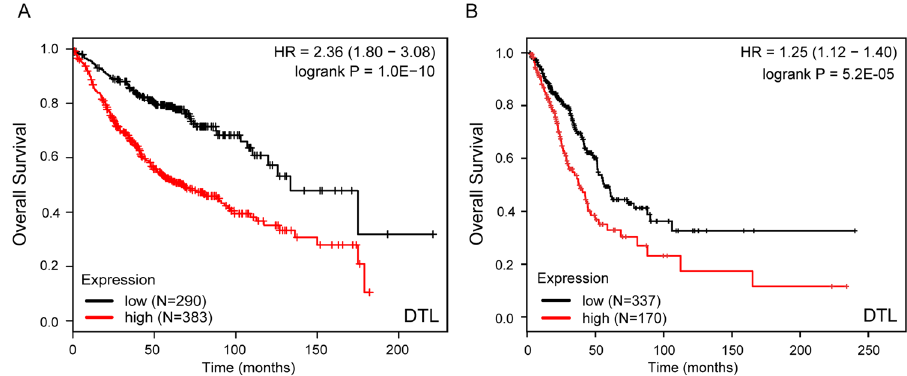
Figure 3. DTL gene expression is associated with overall survival in LuADCs. Survival risk curves are shown for DTL expression in LuADCs using KM-plotter (probe ID 222680_s_at) ( A ) and TCGA ( B ). Low and high expression level of DTL are drawn in black and red respectively. In KM-plotter the threshold for the high and low DTL expression cohorts is automatically calculated. In TCGA, patients were divided into tertiles based on DTL expression levels. The top tertile was defined as the high DTL expression cohort and the remaining patients were defined as the low DTL expression cohort. The p-value represents the equality of survival curves based on a log-rank test.